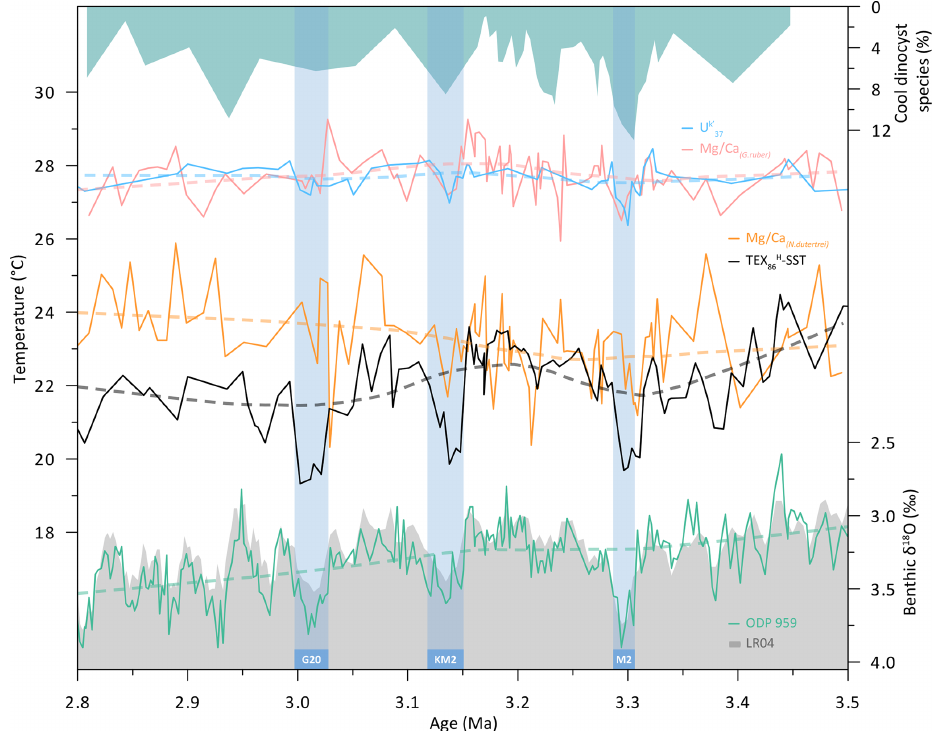
Figure 5. Compilation of late Pliocene multi-proxy temperature data and benthic δ 18 O at Site 959. Mg / Ca ( G. ruber ) (pink) and Mg / Ca ( N. dutertrei ) (yellow) from van der Weijst et al. (2022), benthic δ 18 O from van der Weijst et al. (2020), and LR04 δ 18 O stack (Lisiecki and Raymo, 2005) for reference. Dashed lines are LOESS-smoothed trends, and vertical bands indicate the M2, KM2 and G20 glacial